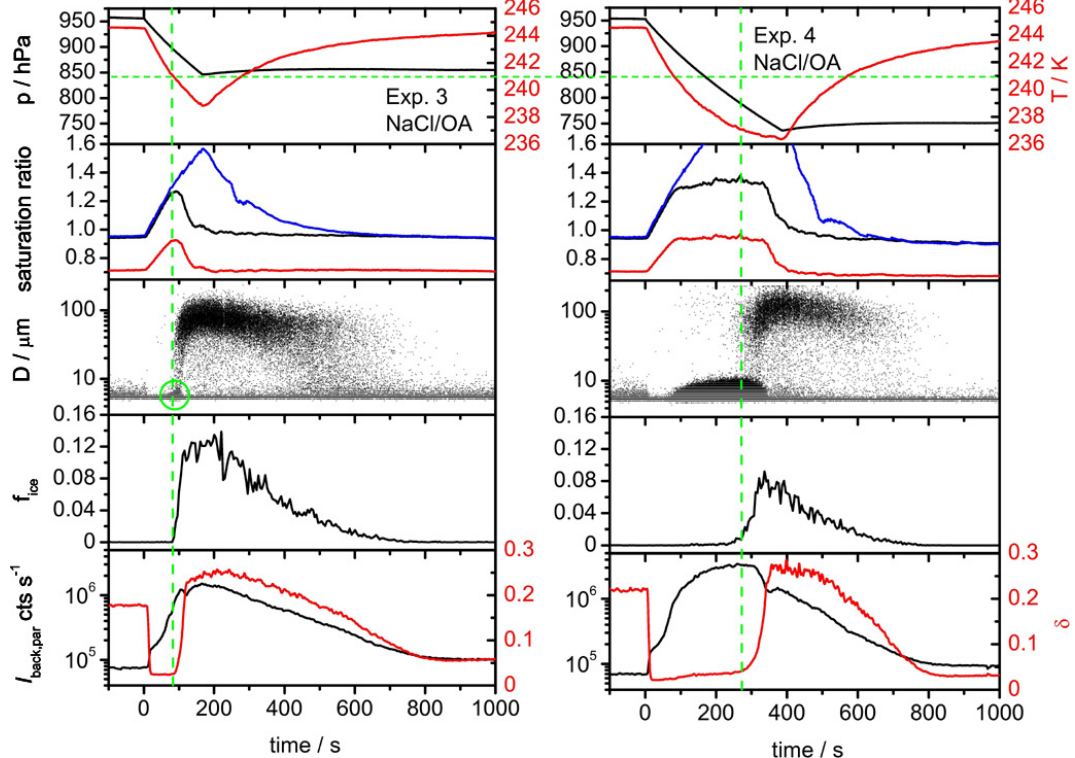
Fig. 10. Time series of various AIDA records during the first expansion cooling cycles from Exp. 3 (OA:NaCl mass ratio: 0.36:5) and Exp. 4 (OA:NaCl mass ratio: 0.07:5) that were started at 244K. The individual panels contain the same measurements as in Fig.